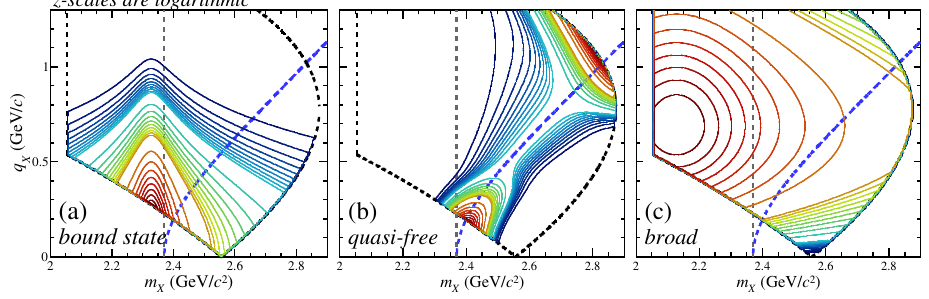
FIG. 6. (color online) 2D spectral functions for (a) the ¯ KNN bound state f K ( m X ,q X ) (see Eq. 8), (b) the QF ¯ K - abs process Figure 2. Two-dimensional distribution of model functions for the fit: (a) the ¯ KNN ( I f F ( m X ,q X ) (see Eq. 10), and (c) a broad distribution f B ( m X ,q X ) (see Eq. 12). For all the figures, the function strength is process, (b) the quasi-free ¯ K absorption process, and (c) the broad component. See the text for more given in a logarithmic scale, where the contours are in the steps of 10% (red–orange), 1% (orange–cyan), and 0.1% (cyan–blue) compared to the maximum density of each function. The vertical gray dotted lines and blue dotted curves are the same as in details. The figure was taken from Ref. Fig. 4.